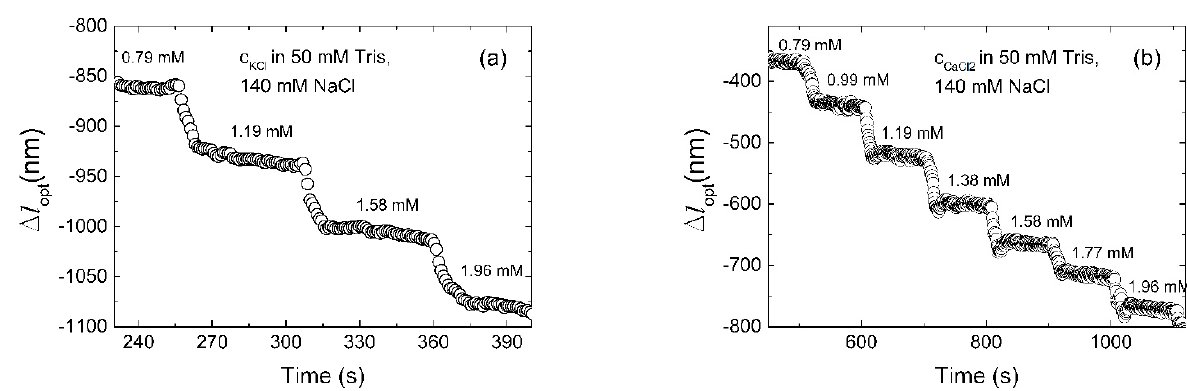
Figure 5. Optical length of the sensor versus time for stepwise 0.794–1.962 mM increase in ( a ) KCl and ( b ) CaCl 2 . Tran-sient swelling when K+ ions are added is slower as a result of the influence of the kinetics of folding of the aptamer, compared to Ca 2+ ions addition.